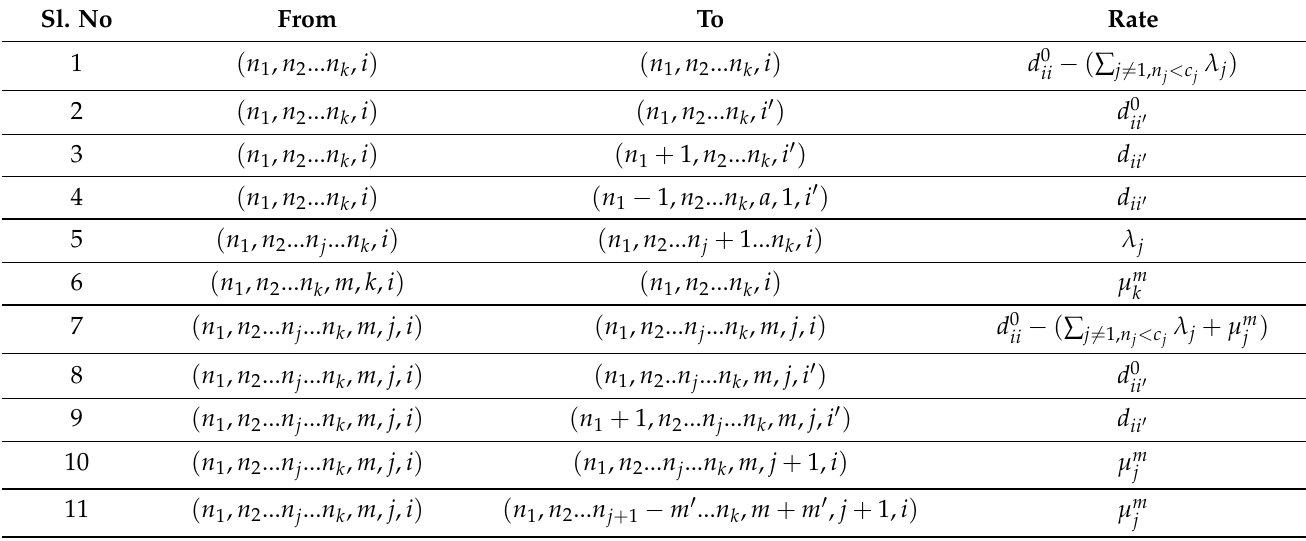
Table 1. Transitions and corresponding rates of transition within level